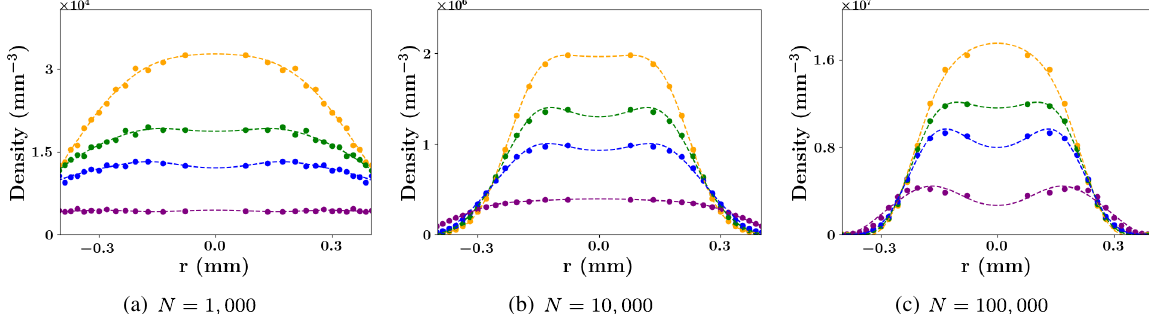
FIG. 2. Average density near the z-median of 30 simulations calculated from bunch profiles evaluated at different times: 5 τ p (yellow), q ffiffiffiffiffiffi m ϵ 0 7 τ 10 τ τ ¼ 2 π 6 τ p (green), p (blue), and p (purple) where p ne 2 number of electrons, N . Dotted lines represent spline fits of order 3 with 10 knots.